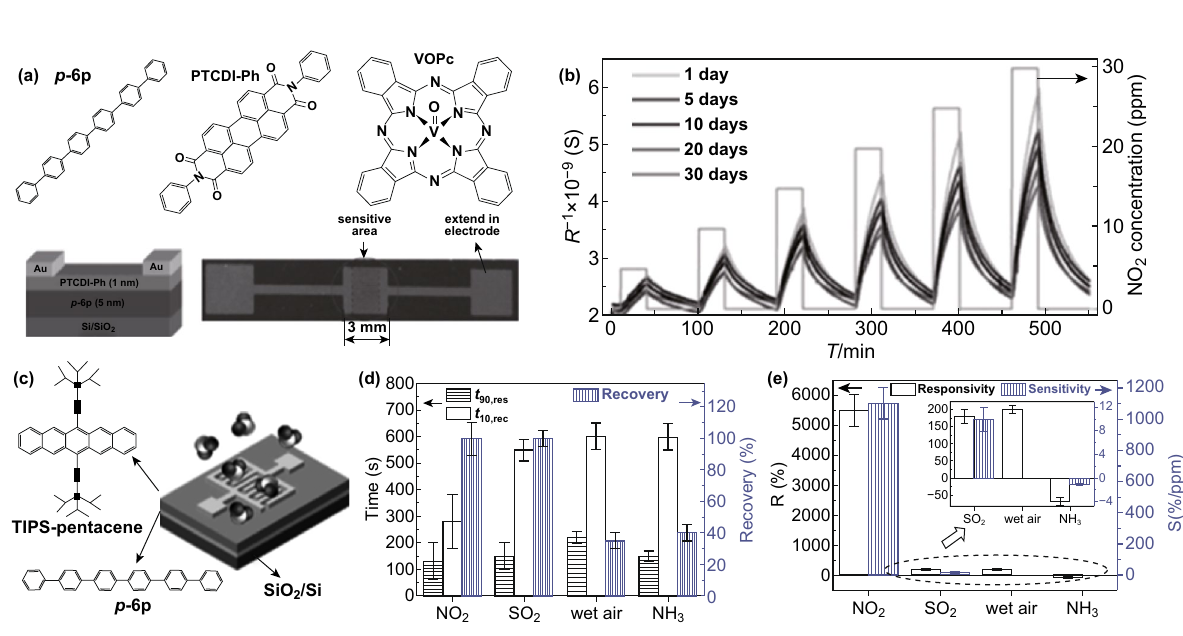
Fig. 7 a Sensor device configuration and molecular structures of the materials. b The relative response of 1 nm PTCDI-Ph/5 nm p-6P film to NO 2 pulses. The relative response curve is plotted as a function of time as the devices become exposed to different NO 2 concentrations. Repro- duced with permission [66]. Copyright 2013, Wiley–VCH. c Sensor device configuration and molecular structures of the materials. d The t 90,res , t 10,rec and relative recovery after 10-min N 2 pulse of the responses to different gases. e Responsivity (R) and sensitivity (S) to different gases. Reproduced with permission [64]. Copyright 2017,